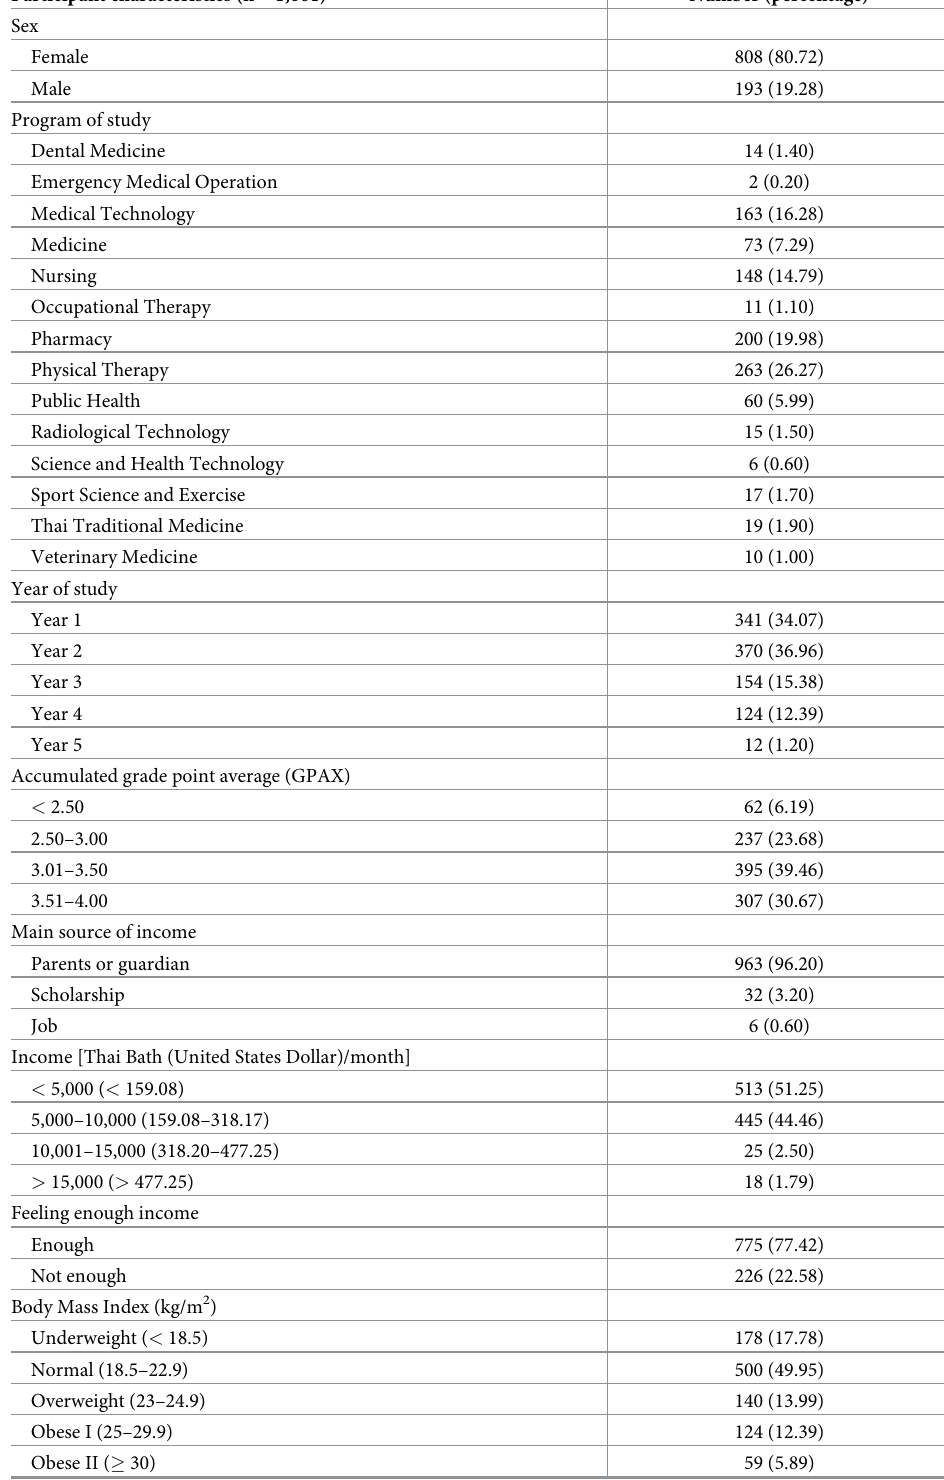
Table 1. Sociodemographic characteristics of the